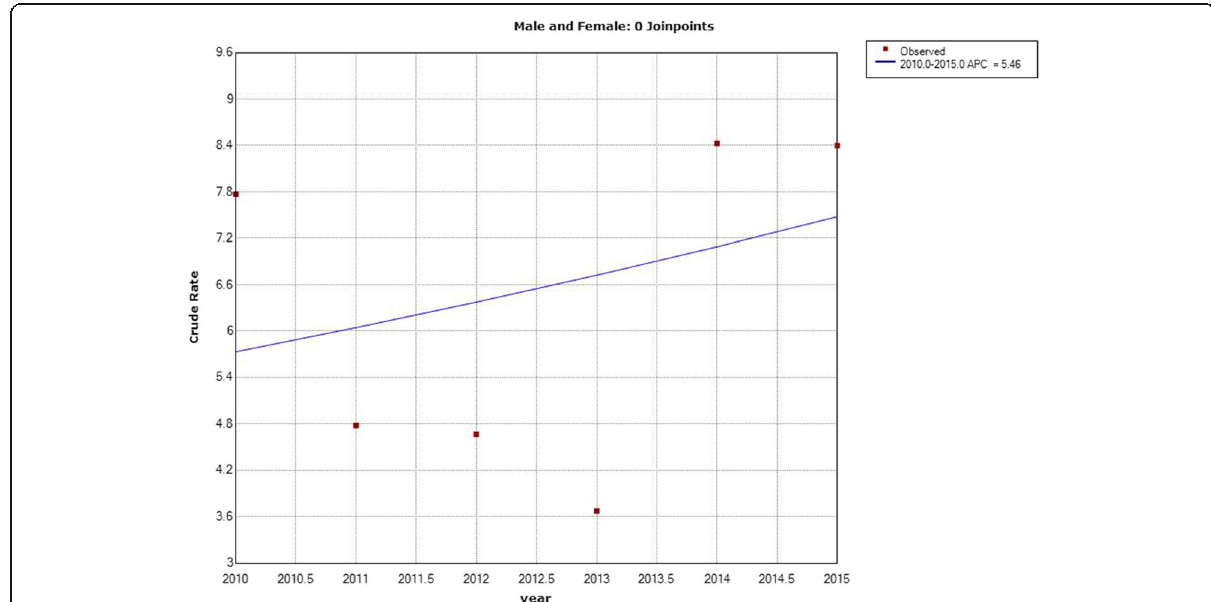
Fig. 1 Fitted segment lines of Overall annual suicide rate per 100,000 population using Joinpoint regression models. ^Indicates that the Annual